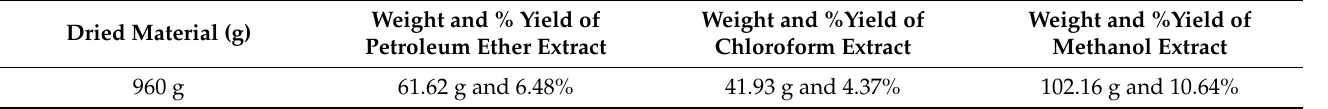
Table 1. The weight and percentage yield of crude extracts from M. lunu-ankenda leaves . Weight and % Yield of Weight and %Yield of Weight and %Yield of Dried Material (g) Petroleum Ether Extract Chloroform Extract Methanol Extract 960 g Isolation and Characterization of 7-Geranyloxycinnamic Acid from the Petroleum Ether Extract of M.